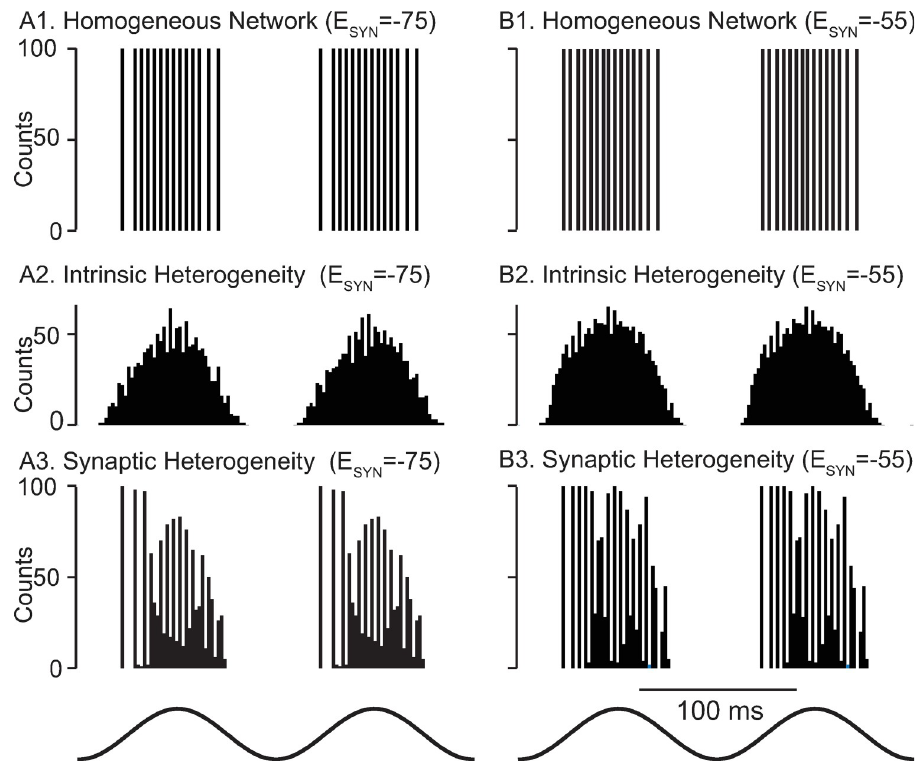
Fig 3. Biophysically calibrated levels of heterogeneity are desynchronizing. Representative spike histograms as a function of time. A1 Hyperpolarizing and B1 Shunting Homogeneous Networks with these parameters: g NA 16805 nS, g Kv1 59 nS, g Kv3 631.7 nS. E L -72 mV and C M 0.0768 nF. g L was 14.7 nS resulting in an input resistance of 68 M Ω , and g and passive parameters across all 100 neurons. A3 Hyperpolarizing and B3 Shunting Networks with homogeneous neurons but randomly instantiated synaptic connectivity, conduction delays and synaptic conductances. The optogenetic theta drive (bottom) varied sinusoidally at 8 Hz from 0 to 14 nS in all